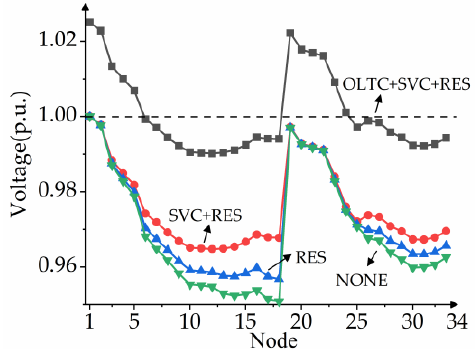
Figure 4. The system voltage distribution at 16 h.